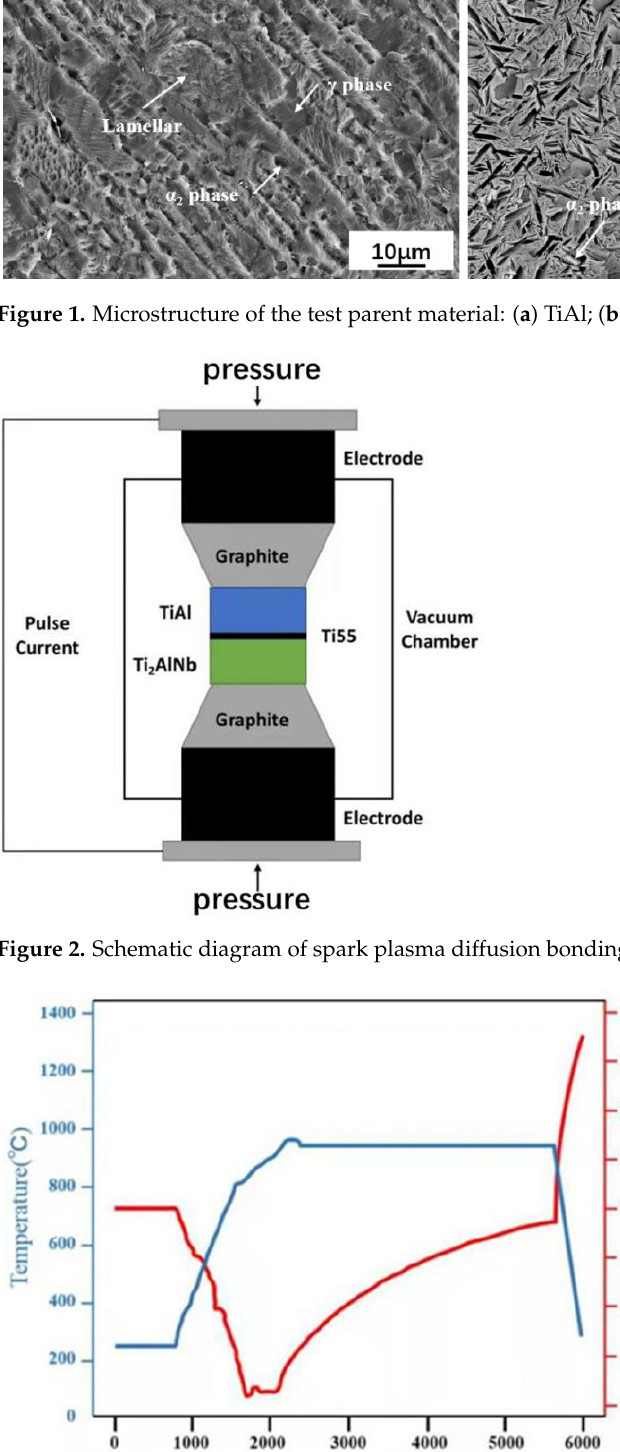
Figure 1. Microstructure of the test parent material: ( a ) TiAl; ( b ) Ti 2 AlNb. Table 1. Chemical composition of TiAl and Ti 2 AlNb (wt.%).